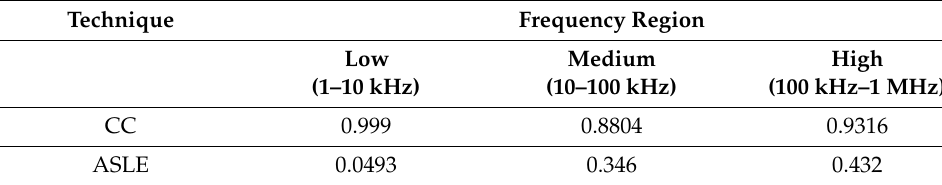
Table 11. Numerical technique for H2-H1 vs. H3-H2.